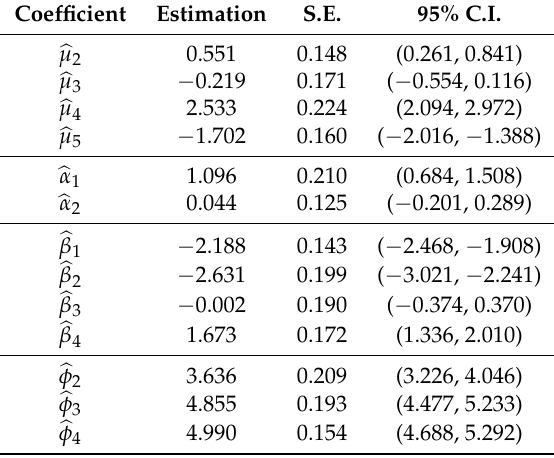
Table A1. Results of fitting the OSM (1) for the French motor claims by policy data set.